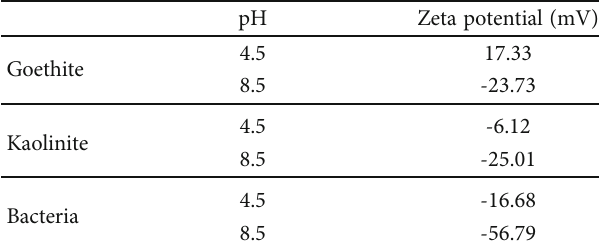
Table 2: The zeta potentials (mV) of goethite, kaolinite, and bacteria at di ff erent